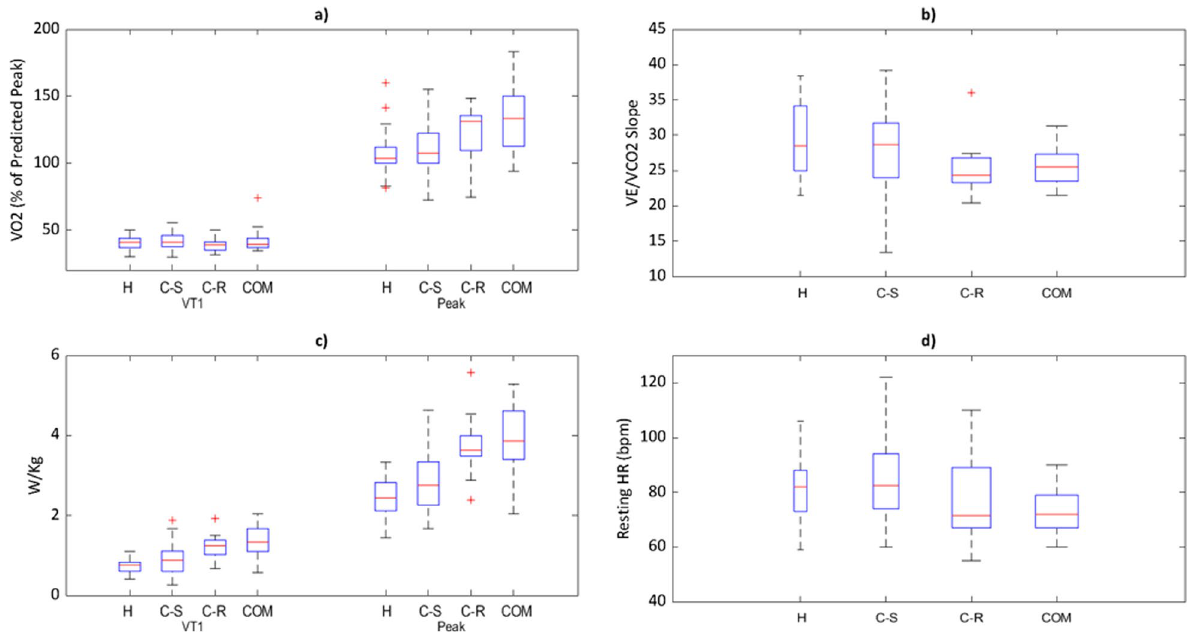
Fig. 3 Cardiopulmonary exercise test (CPET) variables: a percentage predicted VO2 at VT1 and peak, b V ̇ E/V ̇ CO2 slope, c workload (watts per kilogram) at VT1 and peak, d resting heart rate